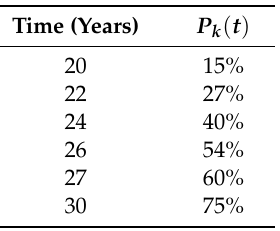
Table 4. Probability of corrosion initiation ( P k ( t )) predicted at di ff erent times measured from t 0 (predictions at t insp = 2 years